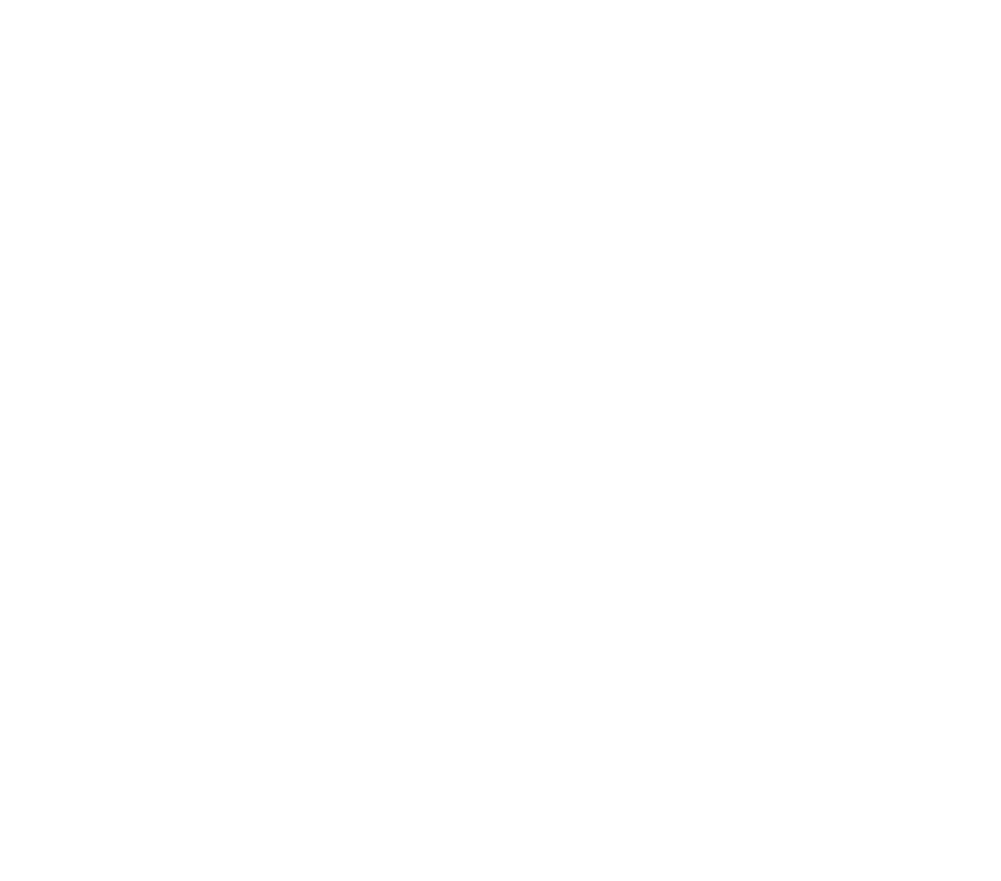
Note: PEE—petroleum ether extract, EE—ethanol extract, CE—chloroform